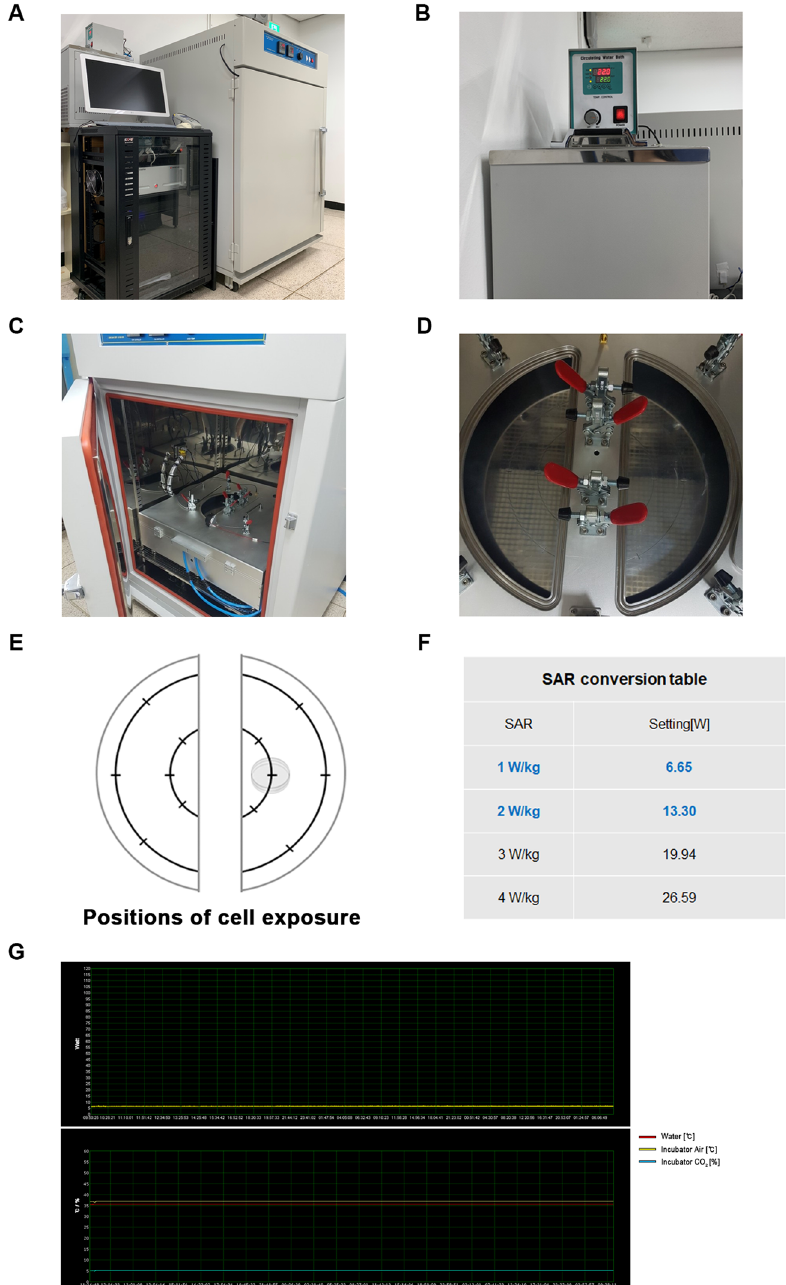
Figure 2. 1.7 GHz LTE RF-EMF cell exposure device and its water cooling system. ( A ) The 1.7 GHz LTE RF- EMF cell exposure device used. ( B ) A water cooling system for the incubator to forcibly lower the heated water temperature by 1.7 GHz RF-EMF. ( C ) The chamber of the incubator with a 1.7 GHz RF-EMF LTE antenna. ( D ) A plate for cell culture dishes in ( C ) are located 13.6 cm from the conical antenna in the center of the exposure chamber. ( E ) A diagram of ( D ) designating the position of the cell dishes for accurate SAR exposure. ( F ) The SAR conversion table for this RF-EMF exposure device. SAR values for precise exposure conditions were obtained through engineering calculations. ( G ) The X-axis in the upper and lower graphs represents the real- time at which the RF-EMF is being exposed to cells. The Y-axis in the upper graph represents the SAR value (Watt) of RF-EMF during the exposure. The Y-axis in the bottom graph shows the temperature of the incubator (yellow line) and the temperature of the refrigerated water-cooling system (red line) of the RF-EMF exposure device during